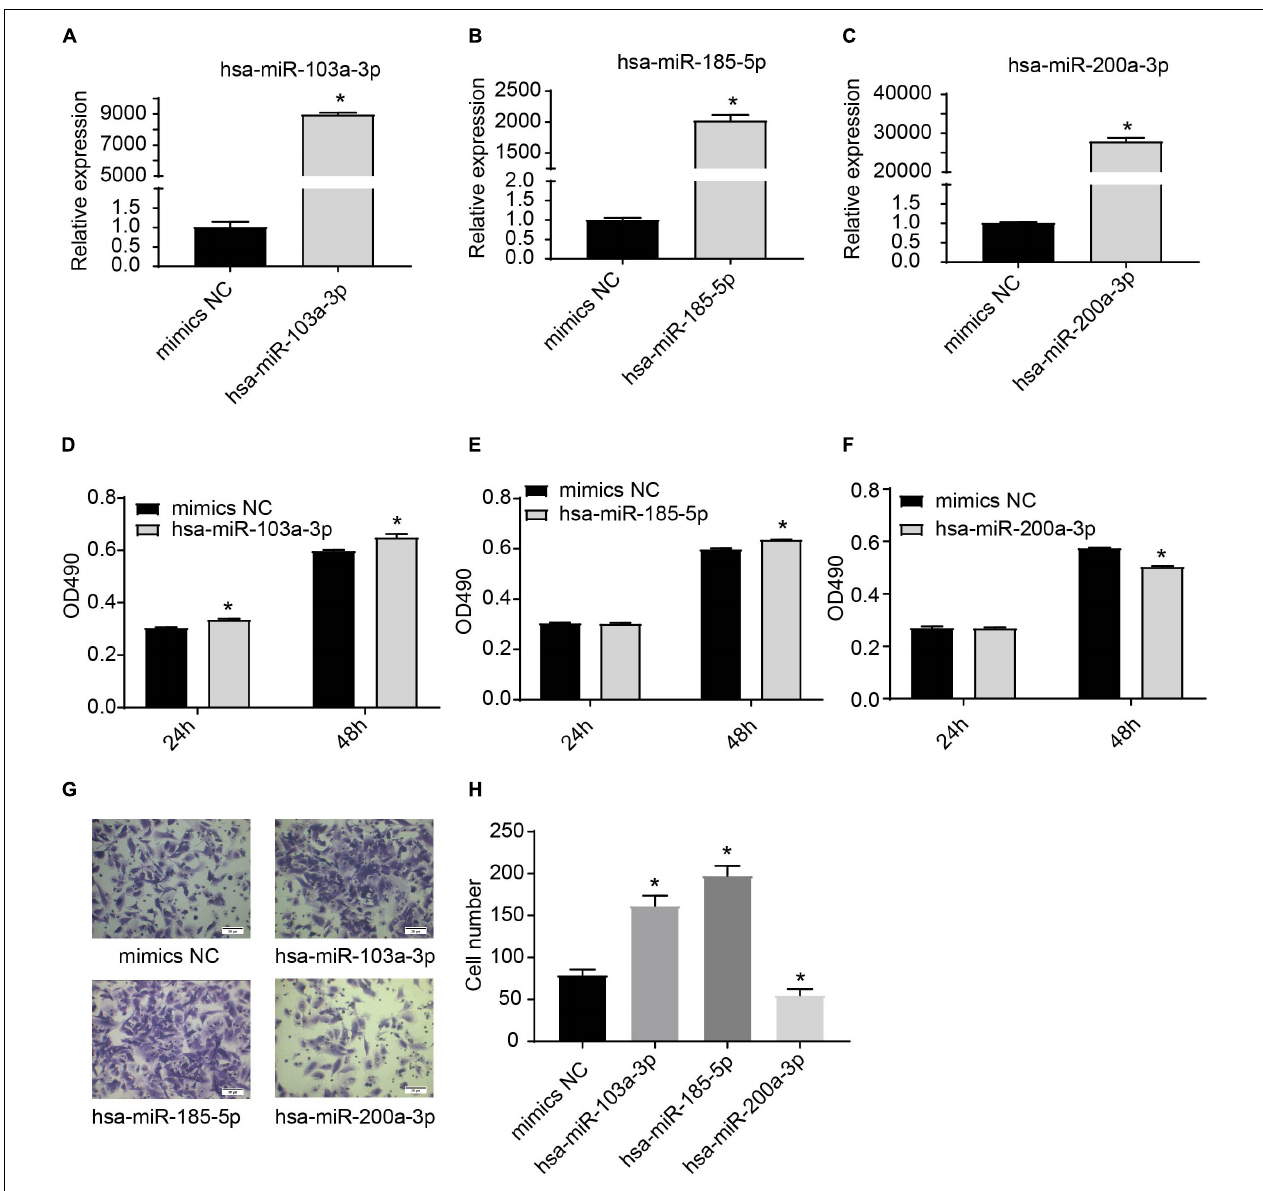
FIGURE 6 | Effects of hsa-miR-103a-3p, hsa-miR-185-5p, and hsa-miR-200a-3p mimics on endothelial cell proliferation and migration. (A–C) Overexpression of hsa-miR-103a-3p, hsa-miR-185-5p, and hsa-miR-200a-3p in HUVECs. HUVECs were transfected with miRNA mimics for 24 h, and expression of miRNAs was determined by RT-qPCR. (D–F) Cell proliferation was determined at 24 h and 48 h after miRNA mimic transfection. Hsa-miR-103a-3p and hsa-miR-185-5p overexpression promoted endothelial cell proliferation, whereas hsa-miR-200a-3p overexpression suppressed endothelial cell proliferation. (G,H) Cell migration was determined at 6 h after miRNA mimic transfection. Hsa-miR-103a-3p and hsa-miR-185-5p overexpression promoted endothelial cell migration. Hsa-miR-200a-3p overexpression inhibited cell migration. * P < 0.05, versus mimics NC group. n =